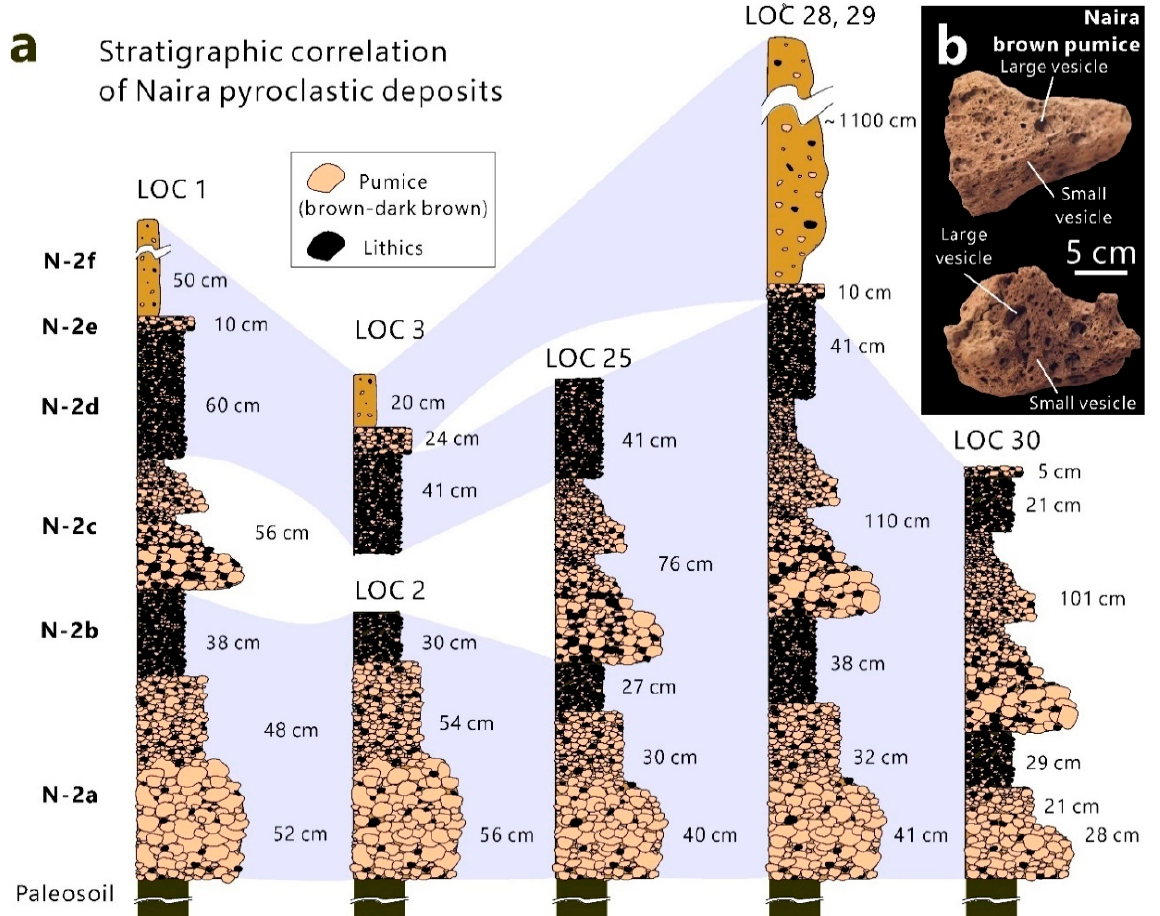
Figure 5. ( a ) Stratigraphic correlation of Naira eruptive units. Brown- and black-colored grains represent brown pumice and lithics, respectively. ( b ) Representative images of Naira brown pumice.